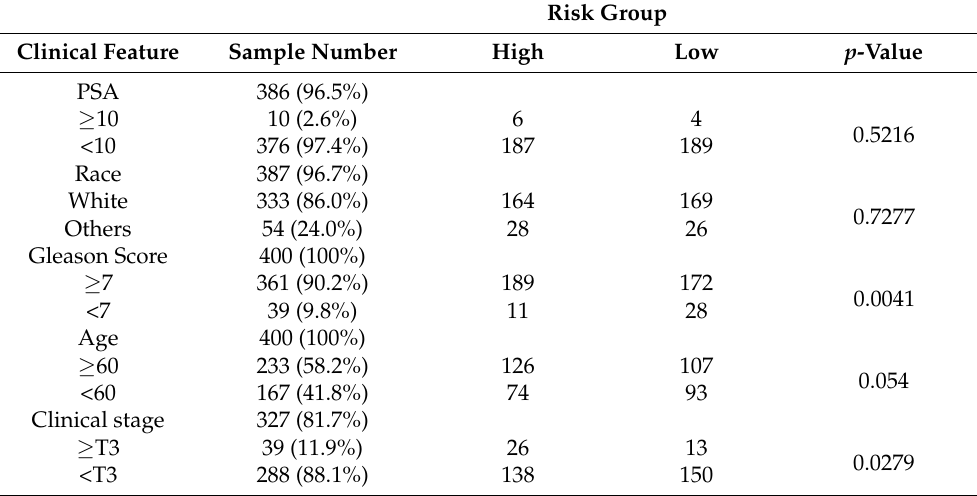
Table 2. Correlations between Clinicopathologic Features and the Risk Score in the Training Set.